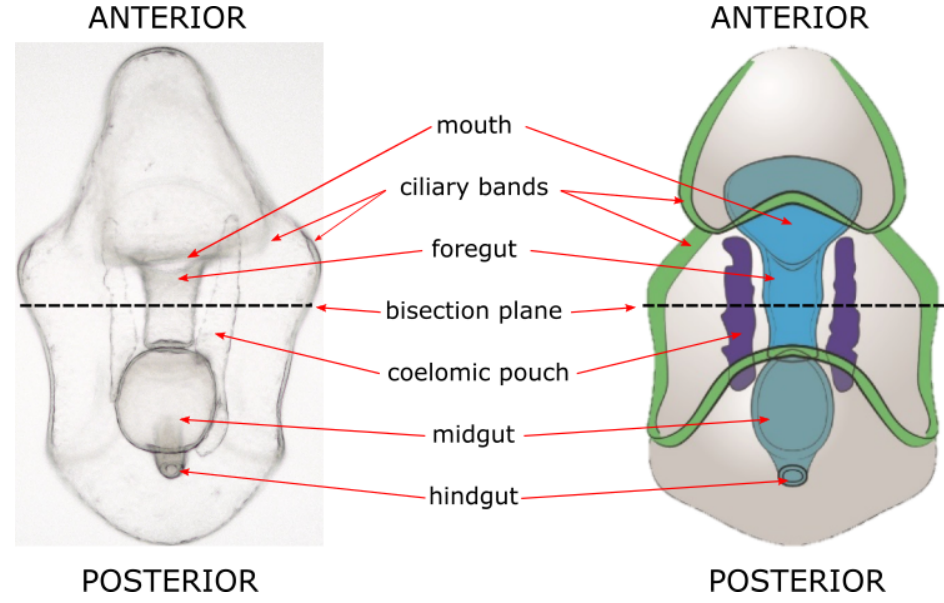
Figure 1. Sea star bipinnaria larval morphology. Left, a light microscopy image of a larva of a sea star ( Patiria miniata ). Large structures are easy to identify and tissues are transparent, making both light and fluorescent microscopy advantageous. Right, a schematic of major sea star larval structures.